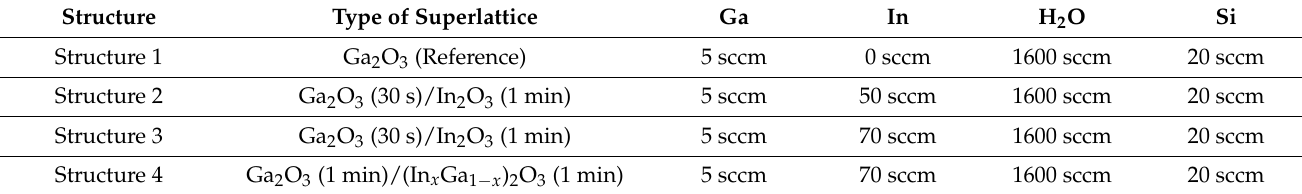
Table 1. Detail information about respective superlattice structure. Structure